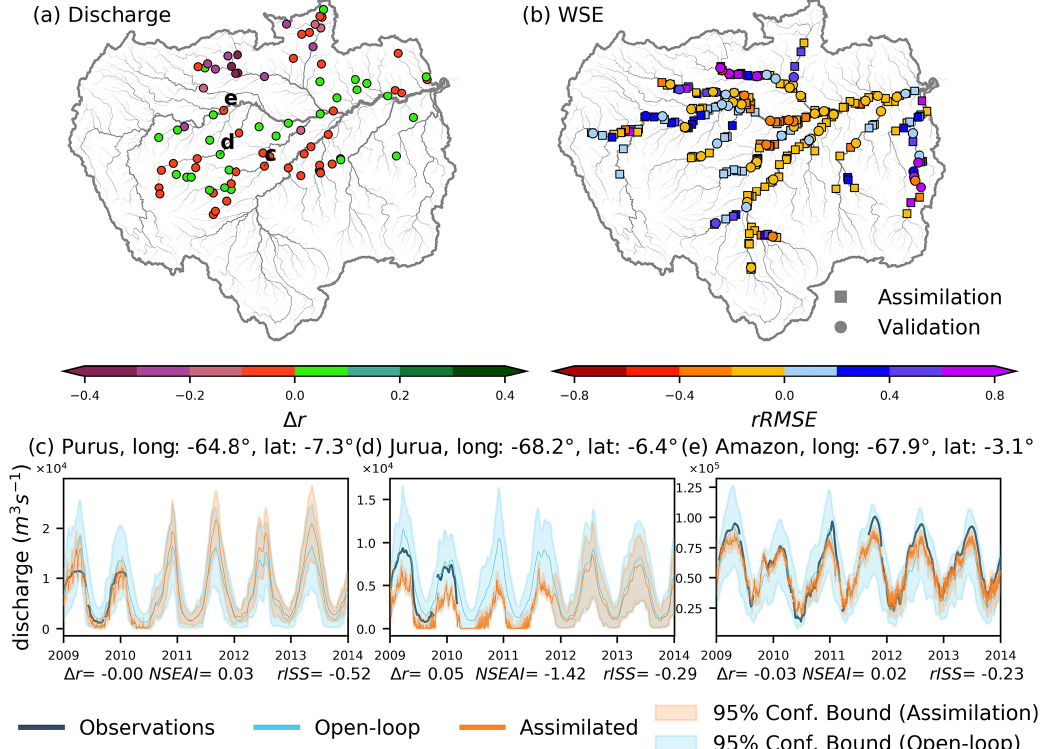
Figure 4. (a) Difference in the correlation coefficient of river discharge ( (cid:49) r) and (b) the relative root mean square error (rRMSE) in water surface elevation for DIR. Circles indicate virtual stations used for data assimilation, and squares are virtual stations used for validation on the WSE plots. Hydrographs recorded at Labera on the Purus River, Santos Dumont on the Jurua River, and Santo Antonio Do Ica on the Amazon River are presented in panels (c) , (d) , and (e) , respectively. The locations of the hydrographs shown in panels (c) , (d) , and (e) are presented in panel (a) . Discharge observations are shown in black, assimilated simulation results in orange, and open-loop simulation results in blue. The color range indicates the 95% confidence interval used to calculate the relative interval skill score (rISS). (cid:49) r , the Nash–Sutcliffe efficiency-based assimilation index (NSEAI), and rISS are shown at the bottom of each